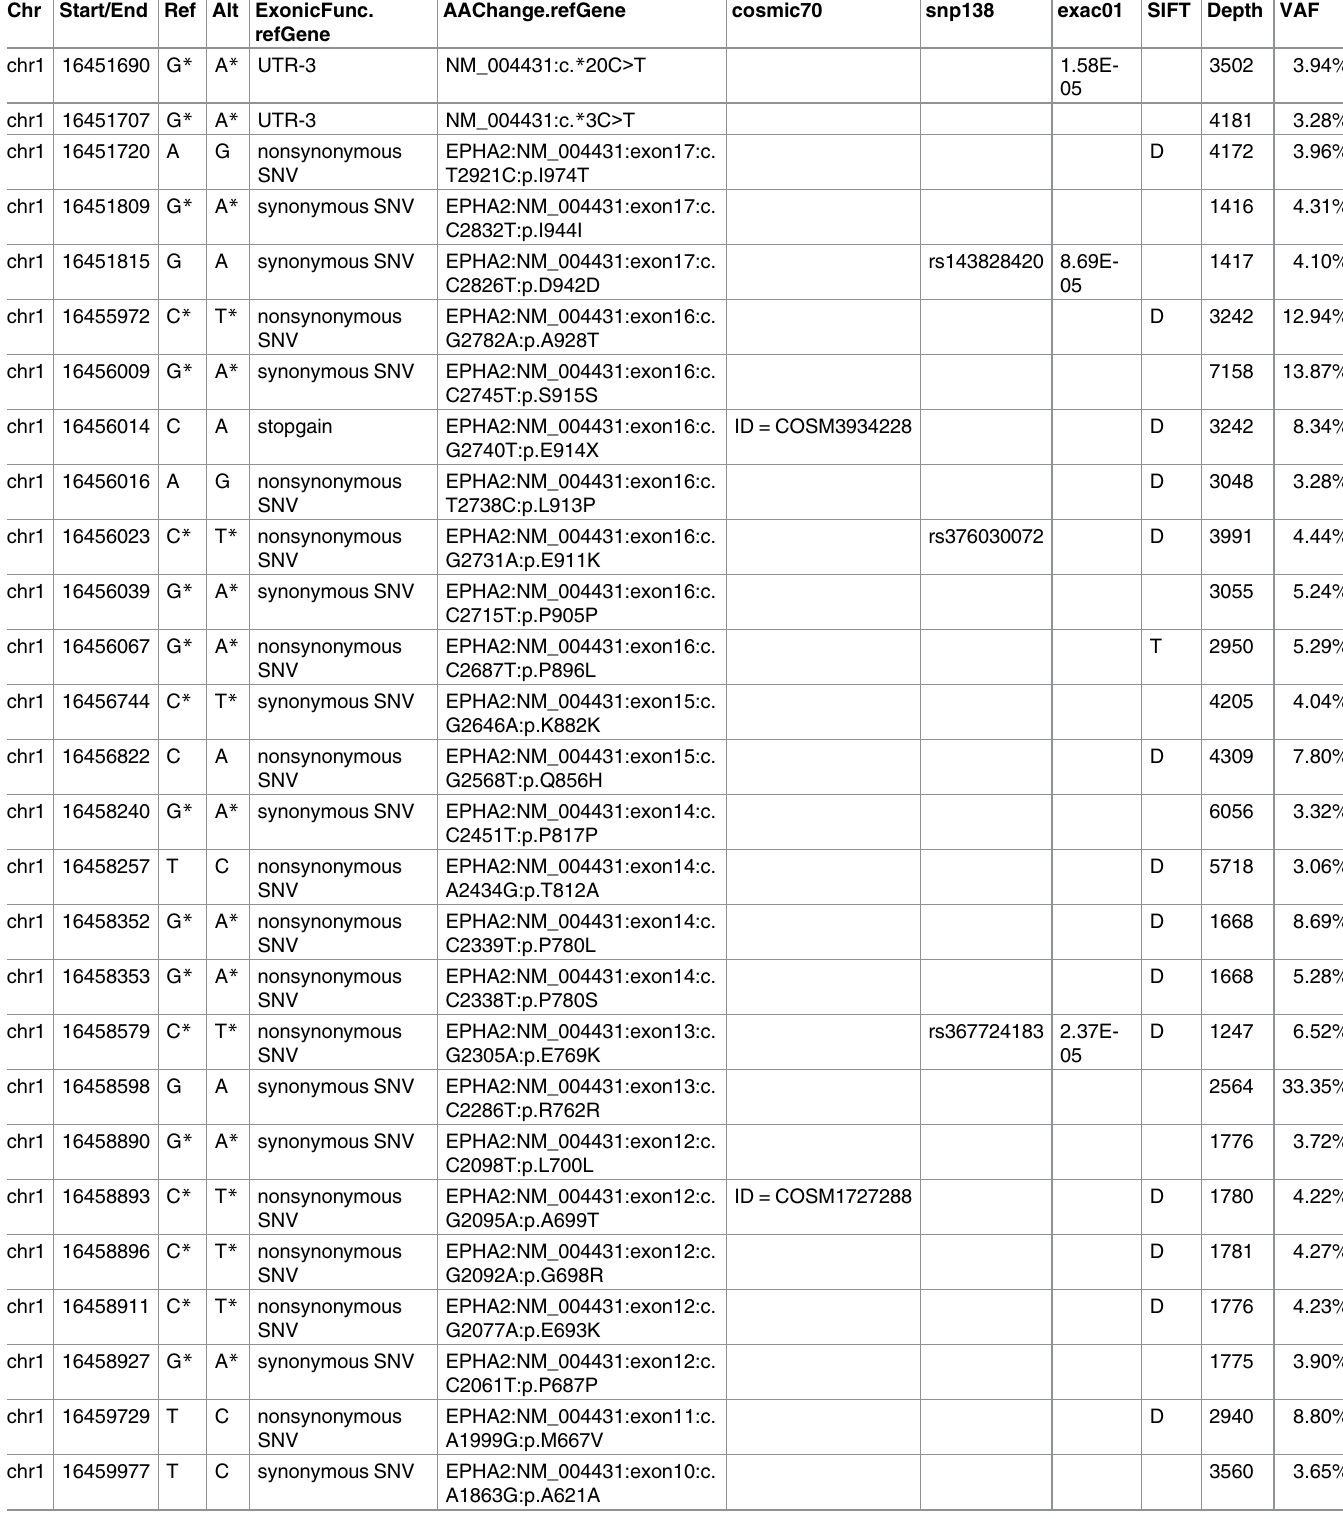
Table 3. Somatic EPHA2 coding SNVs found in the paired clear lens panel (VAF > 3%). Chr Start/End Ref Alt ExonicFunc.